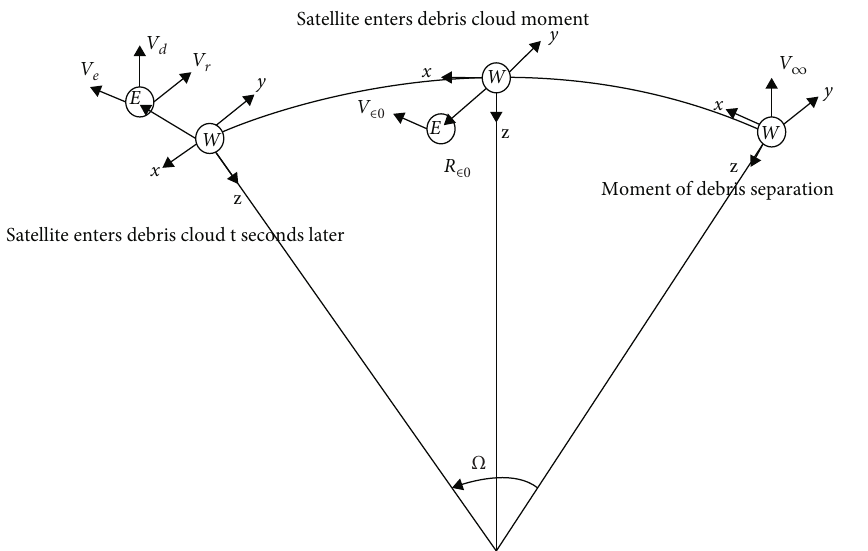
Figure 4: Position-velocity relationship between satellite E and debris cloud centre